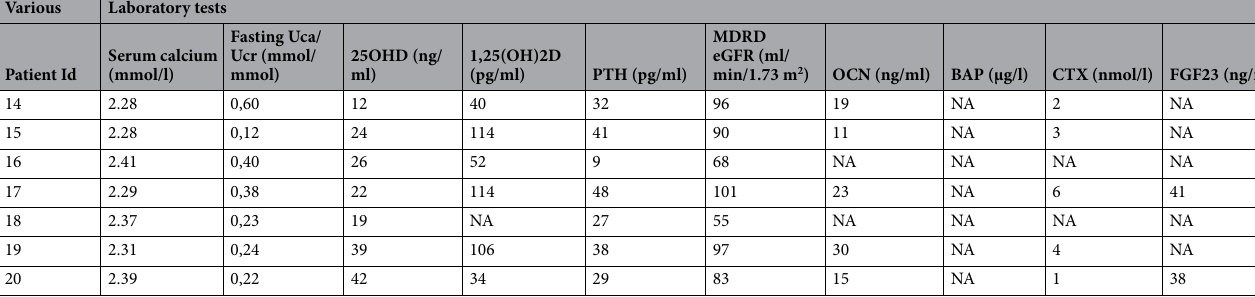
in Table 3. The ACMG classification of SLC34A1 variants is presented in Supplementary Table 1. In addition to SLC34A1 variants, one variant in SLC9A3R1 and three in SLC34A1 were also detected and are presented in Table 2. The variant in the SLC9A3R1 gene has already been reported in patients with renal phosphate leak; this variant is responsible for functional anomalies: increased generation of cyclic AMP (cAMP) in response to parathyroid hormone (PTH) leading to inhibition of renal phosphate transport 10 . In addition, the CYP24A1 gene was analyzed for the 3 patients with PTH either low or below the limit of detection, without detection of pathogenic variants. Expression of wild‑type NPT2c in HEK cells: RT‑qPCR, immunofluorescence and phosphate uptake. In order to study the consequences of the SLC34A3 variants on NPT2c function we first character- ized the properties of wild type NPT2c expressed in HEK cells, which do not naturally express NPT2c. We trans- fected HEK cells with NPT2c cDNA and checked by RT-qPCR experiments the expression of NPT2c mRNA (Fig. 1a). Immunofluorescence experiments confirmed that wild type NPT2c was expressed at the plasma mem- brane of HEK transfected cells (Fig. 1b). We then checked that wild type NPT2c membrane expression was asso- ciated with an increase in HEK cell phosphate uptake. We first studied the time dependance of phosphate uptake in HEK cells transfected with a fixed amount of NPT2c plasmid. Phosphate uptake measured until 20 min increased with time (Fig. 1c). All the subsequent uptake experiments were performed at 10 min of incubation. We transfected HEK cells with increasing amount of wild type NPT2c plasmid. Phosphate uptake increased with NPT2c cDNA amount. (Fig. 1d). Functional characterization of NPT2c mutants. We studied the consequences of 13 variants (11 mis- sense, 1 nonsense and 1 frameshift) that result in a modification of the NPT2c protein sequence. We did not study the consequences of the mutations located in the introns. The NPT2c variants were inserted by site-directed mutagenesis and included in expression vectors. All the cDNA were sequenced to verify the presence of the variant and the absence of additional modification in the sequence. We then transiently expressed the cDNAs of these mutants in HEK cells. We checked NPT2c RNA expression in transfected HEK cells by rt-QPCR (Fig. 2). NPT2c mRNA was detected in all transfected cells but was undetectable in non-transfected HEK cells. We assessed the functionality of the NPT2c mutants by meas- uring phosphate uptake in the transfected HEK cells (Fig. 3a). Phosphate uptake of HEK transfected cells was compared to sham-transfected cells. Phosphate transport was significantly affected in some but not all NPT2c mutants. Mutants c.241G > A (p.Gly81Ser) and c.1585A > T (p.Ile529Phe) exhibited phosphate transport capac- ity similar to wild type NPT2c (Fig. 3a). Phosphate uptake was moderately diminished (24–32%) in HEK cells transfected with mutants c.781A > G (p.Ser261Gly), c.947C > T (p.Thr316Met) or c.1208T > G (p.Met403Arg). Phosphate accumulation was almost completely abolished in 8 mutants: c.496G > A (p.Glyc166Ser), c.575C > T (p.Ser192Leu), c.1046_1047delTG (p.Val349Alafs*243), c.1242C > G (p.Tyr414*), c.1361A > G (p.Asn454Ser), c.1453C > T (p.Arg485Cys), c.1454G > A (p.Arg485His) and c.1496 T > C (p.Leu499Pro) (Fig. 3a). Based on these results, we reclassified the ACMG class of each patient as the final ACMG class (Tables 2, 3). The ACMG class